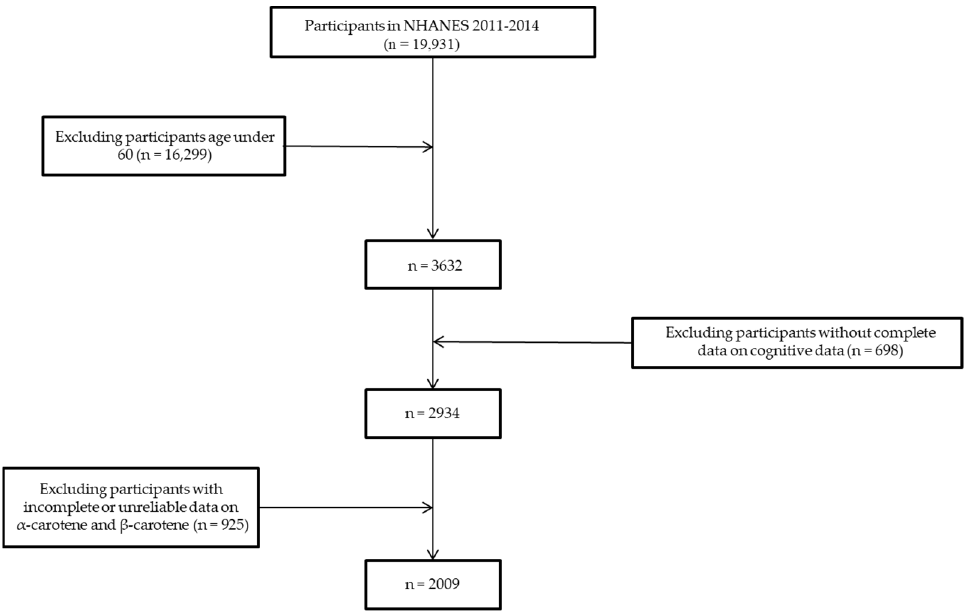
Figure 1. Flow chart for the selection of eligible participants for this study.